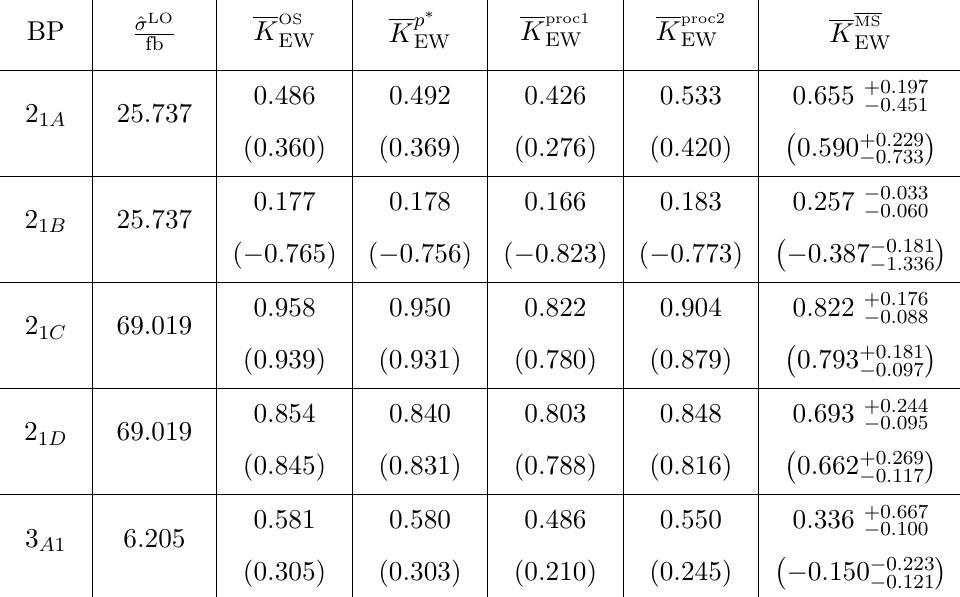
Table 5 . The NLO electroweak K-factors for the process g + g points (BP) in the alignment limit are shown. They are de(cid:12)ned in table 1. Both K NLO and K NLO (in parentheses) are shown. The renormalization scale has been set to (cid:22) 0 as de(cid:12)ned in EW eq. (3.4) for the MS scheme. The lower (upper) value of the MS result corresponds to the